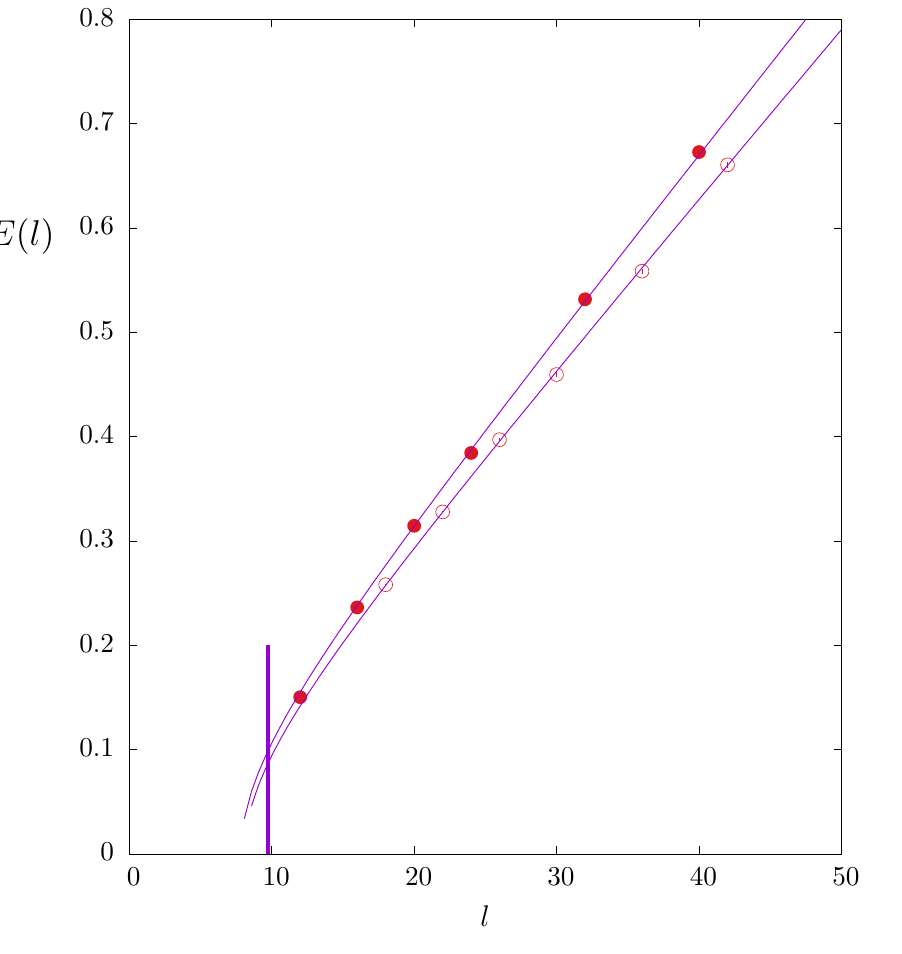
Figure 9 . Ground state energy of a (cid:13)ux tube of length l in SO(8) at (cid:12) = 86, (cid:15) , and in SO(6) at (cid:12) = 46, (cid:14) . Nambu-Goto (cid:12)ts shown. Vertical line is location of SO(6) decon(cid:12)ning transition.